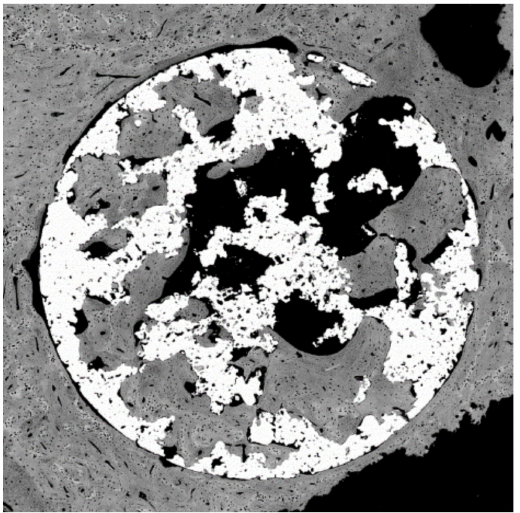
Figure 17. Colonization of bone inside the porous of a bioactive porous dental